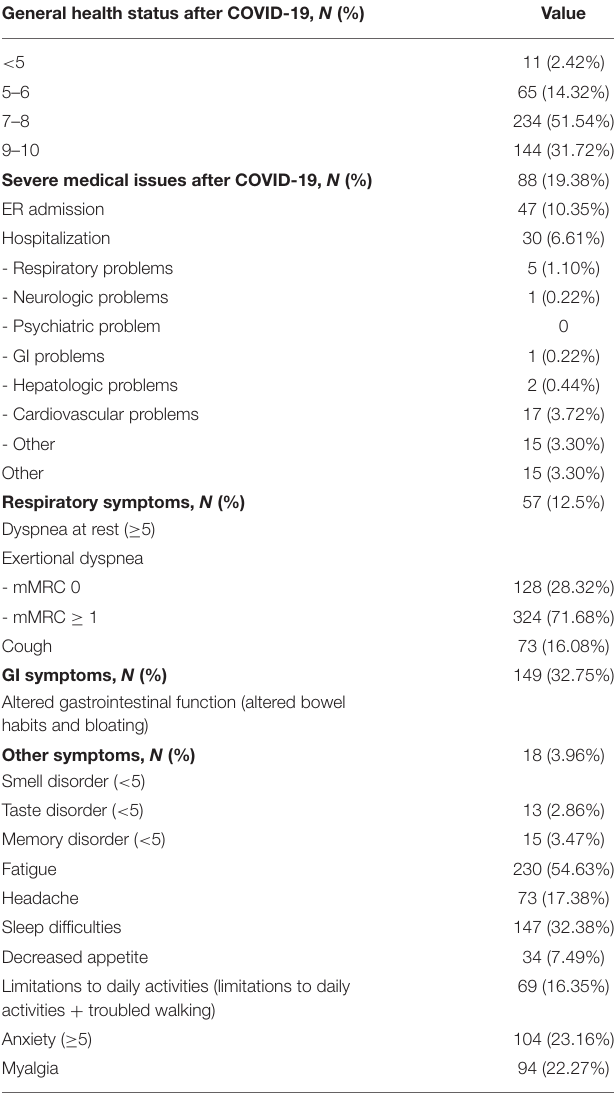
TABLE 2 | Persistent symptoms and sequelae investigated among patients with COVID-19, discharged alive and who agreed to follow up interview ( n = 456). General health status after COVID-19, N